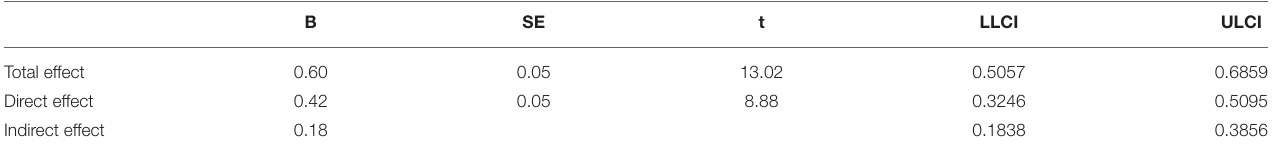
TABLE 3 | Bootstrapping results of mediation